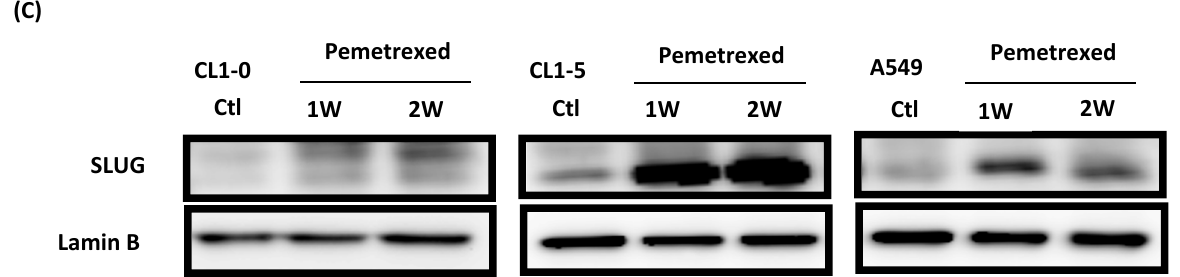
Figure 4. FD triggers the overexpression of SLUG transcription factors in NSCLC cells. The expression of SLUG and E-cadherin of NSCLC cell lines treated with FD or pemetrexed (30 ng/mL) were detected through RT-qPCR and Western blotting. ( A ) Gene expressions of SLUG and E-cadherin in cells treated with pemetrexed (30 ng/mL) for 1, 2, or 3 weeks increase. ( B ) Gene expressions of SLUG and E-cadherin in cells undergoing FD treatment for 2 or 4 weeks increase. In parallel, ( C ) nuclear translocation of SLUG increased detected through Western blotting. * p < 0.05; ** p < 0.01.